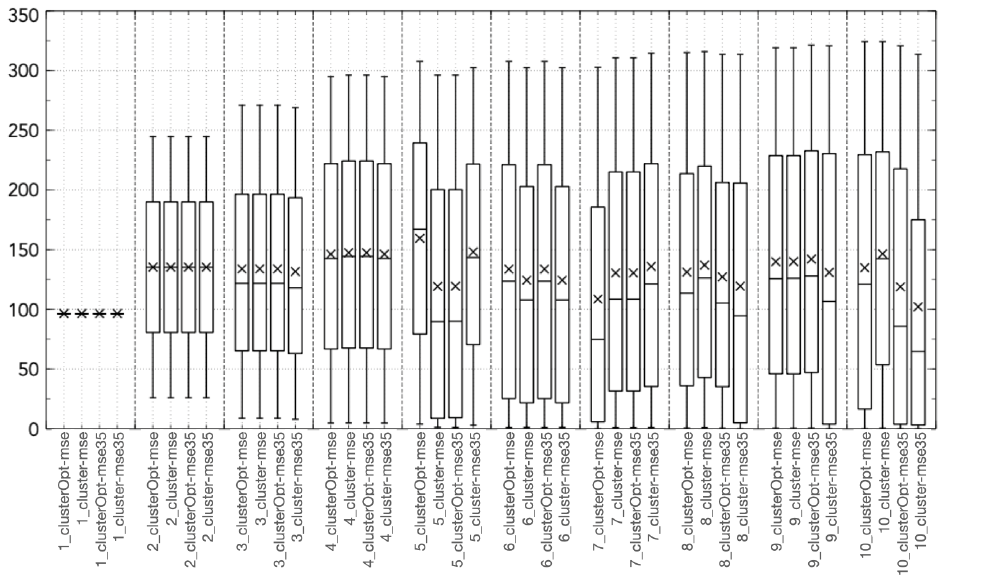
Figure 7. Boxplot of coordinate 5 ( u 2 ( t ) , daily solar radiation at time t ) of the centroid [kw/h].